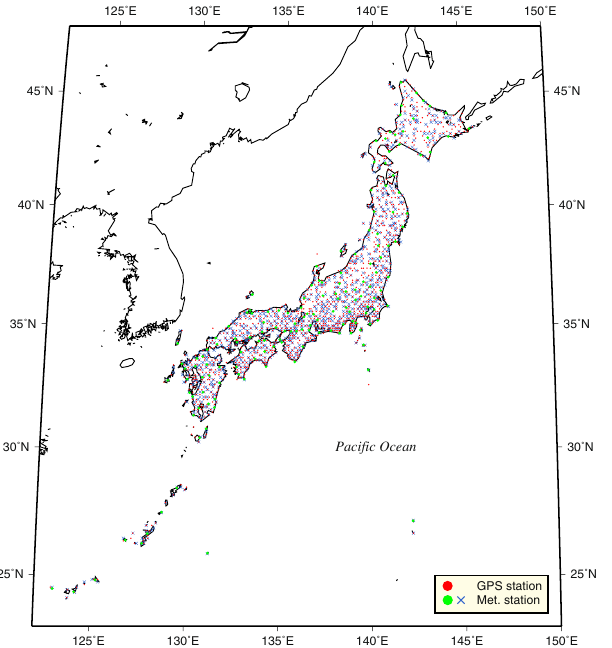
Figure 1. Observational stations. Map of the study area showing GPS and surface meteorological stations in Japan. Red circles indicate GPS stations. Blue crosses and green circles indicate meteorological stations. We use surface pressure, air temperature and relative humidity observed at the green circles and surface air temperature and precipitation observed at the blue crosses. The map was created using GMT Generic Mapping Tools (GMT) 27 version 5.1.1 available at